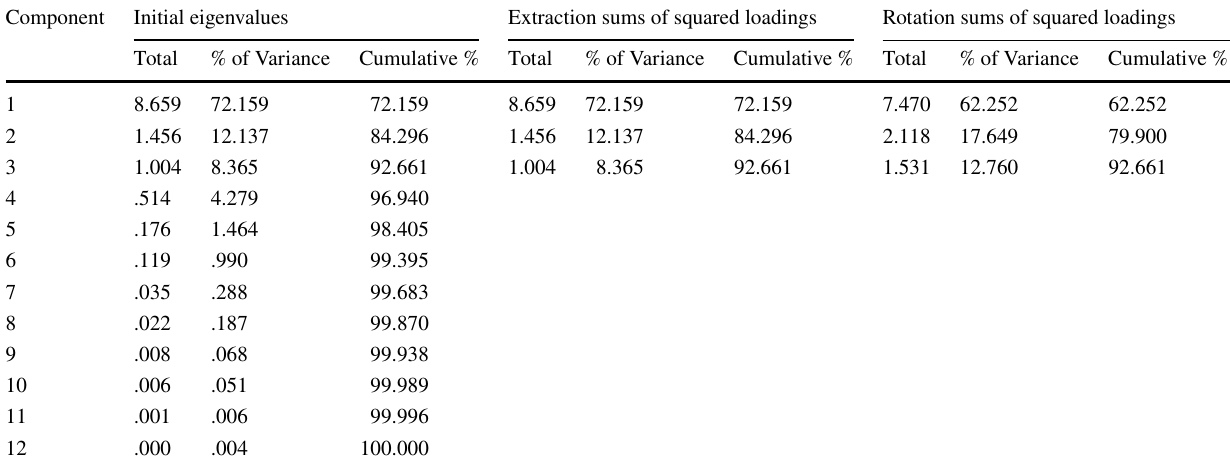
Table 8 Total variance explained from R mode Factor analysis